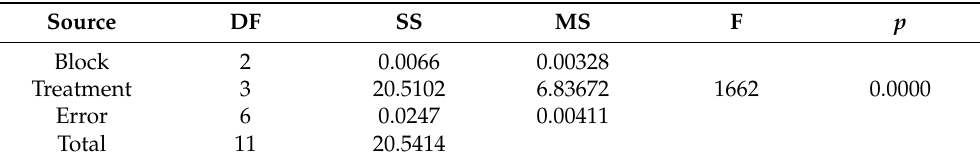
Table 2. Analysis of variance for impact of different irrigation treatment on yield.